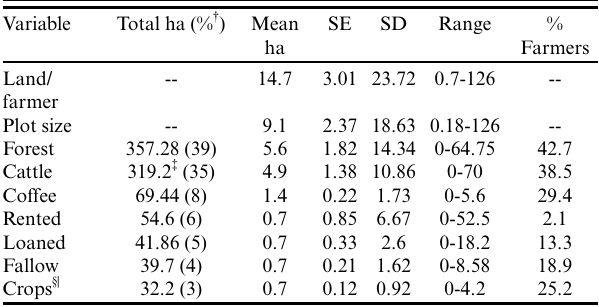
Table 2 . Land and land use distribution among opportunity cost survey respondents (n =